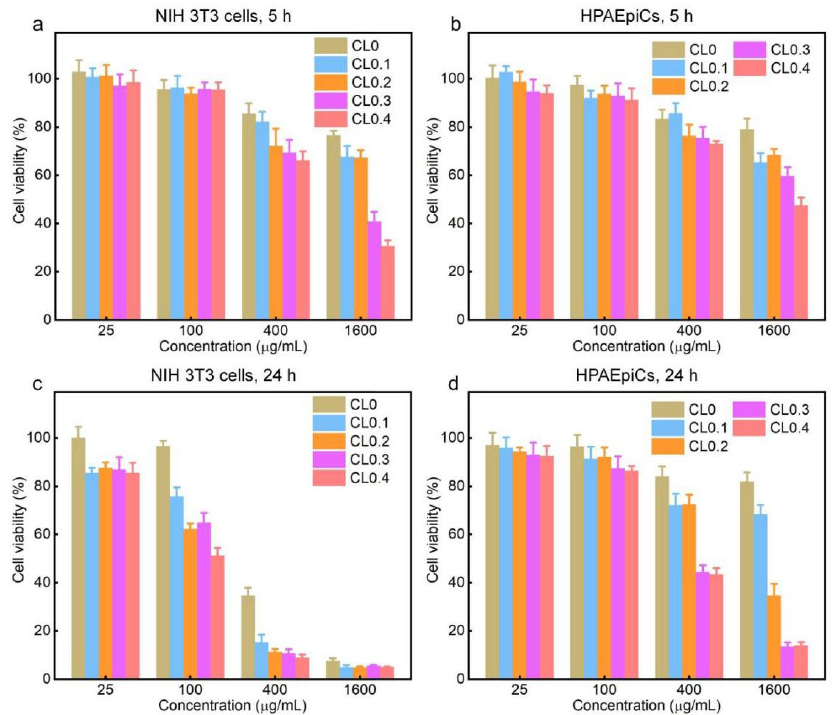
Figure 5. Relative viabilities of NIH 3T3 cells and HPAEpiCs after incubation with different CLs for 5 and 24 h. ( a ) NIH 3T3 cells, 5 h, ( b ) HPAEpiCs, 5 h, ( c ) NIH 3T3 cells, 24 h, ( d ) HPAEpiCs, 24